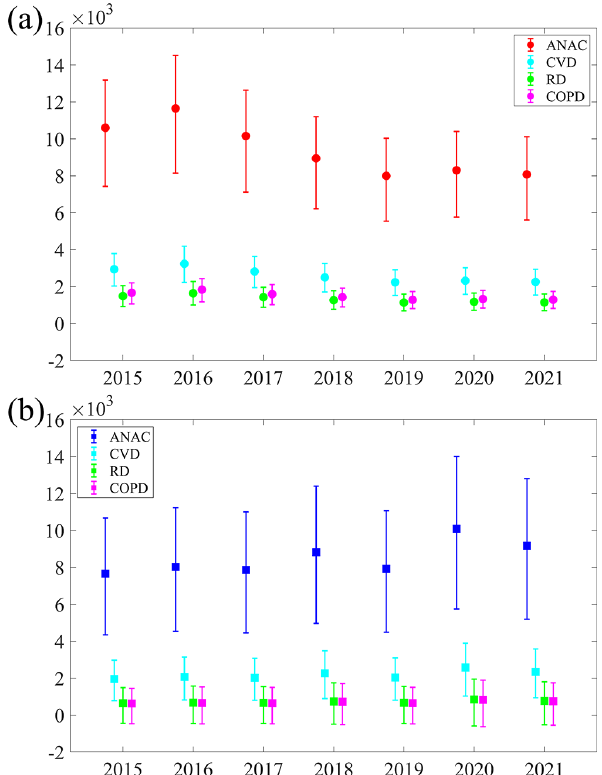
Figure 3. Premature mortality from ANACs, CVDs, RDs and COPDs attributable to (a) PM 2 . 5 and (b) O 3 in Chengdu from 2015 to 2021. The dots represent the mean estimate, and the whiskers represent